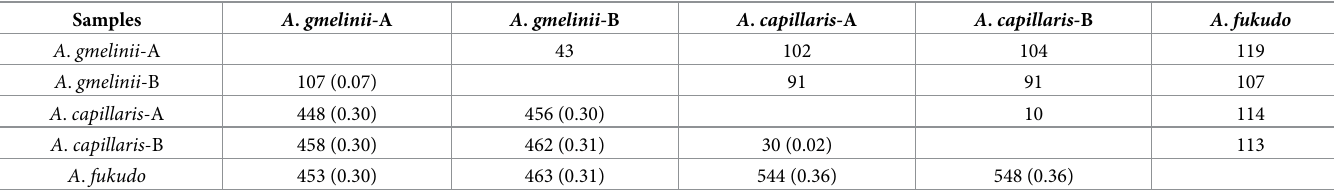
Table 2. The number of SNPs and InDels found in chloroplast genomes of three Artemisia species. Samples